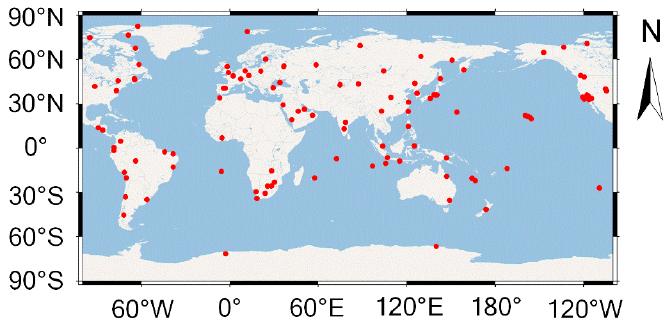
Figure 1. The distribution of International GNSS Service (IGS) stations used for analysis.